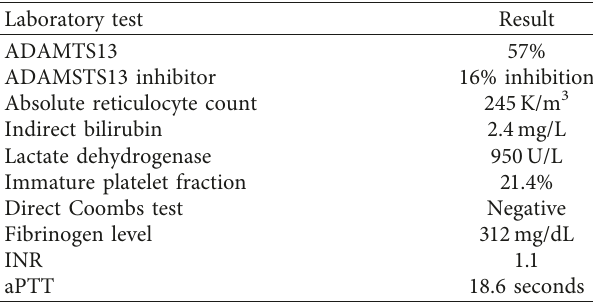
Figure 2: MRI of the thoracic and lumbar spine: compression vertebral fracture at L4 with retropulsion of the posterior vertebral body causing severe spinal stenosis. Extraosseous extension of tumor into ventral epidural space at T12. Table 1: Laboratory test